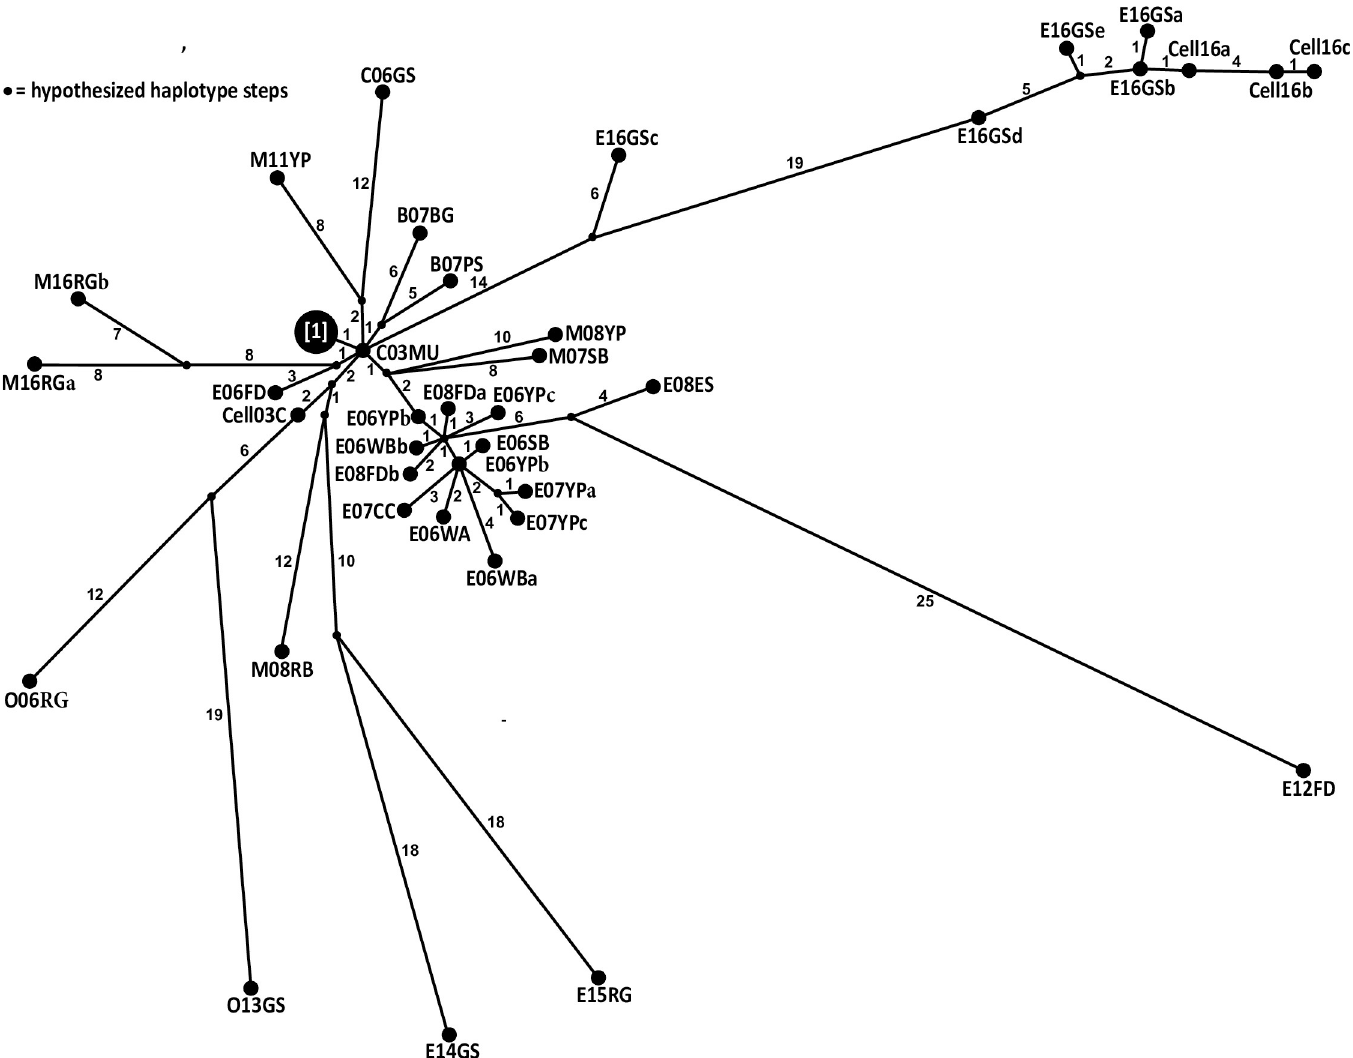
Fig 2. Haplotype network showing genetic relationships among 48 VHSV-IVb whole genomes determined by us with PopART freeware (http://popart.otago.ac.nz). Circles are sized according to haplotype frequency (number of isolates). Numbers inside parentheses designate NT differences between each haplotype and the original haplotype, C03MU � . Individual isolates sharing a common haplotype (labelled “1” here) include: C06NP, C06RB, C06SR, C06YP, C06FD, E06WBc, M08AMa,b, C08LEa, b, and C09MU); these are termed the C06NP group. Small, unlabeled black circles = hypothesized haplotype